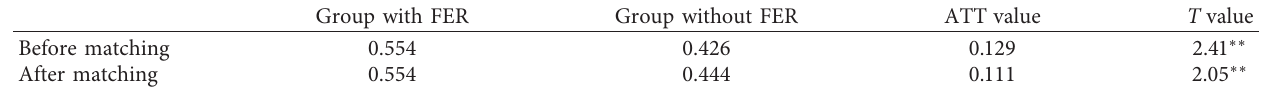
Table 5: Estimation results of propensity score